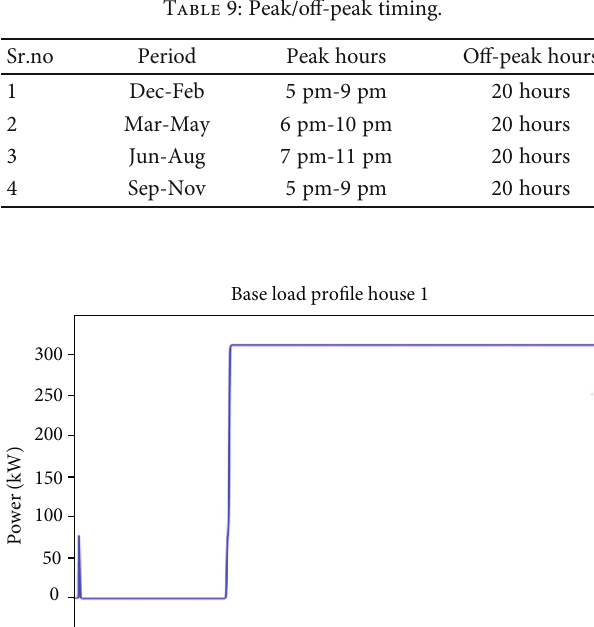
Figure 29: Nanogrid power consumption without EMS.